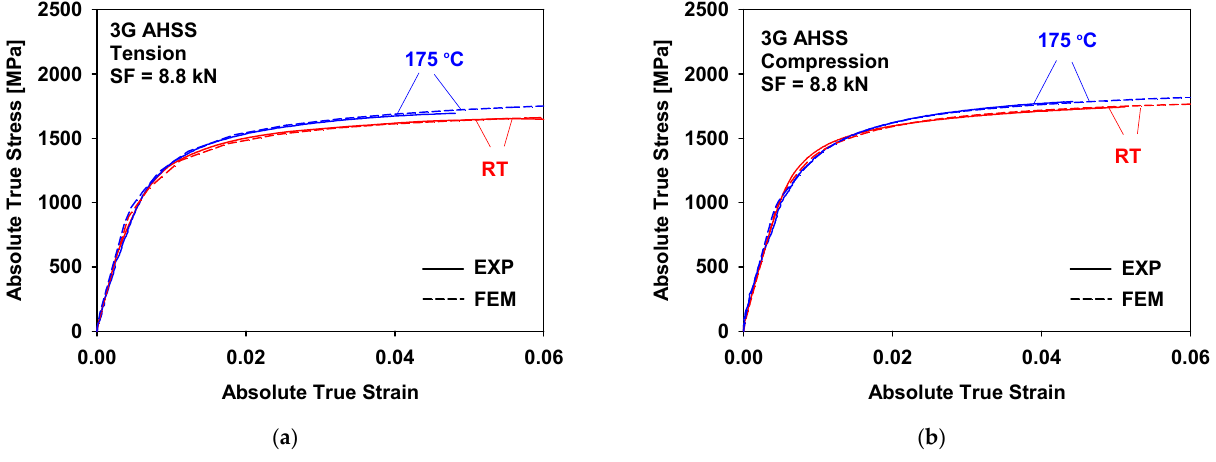
Figure 17. Comparison of the measured and FE calculated absolute true stress–strain curves of 3G AHSS: ( a ) tensile and ( b ) compressive tests.